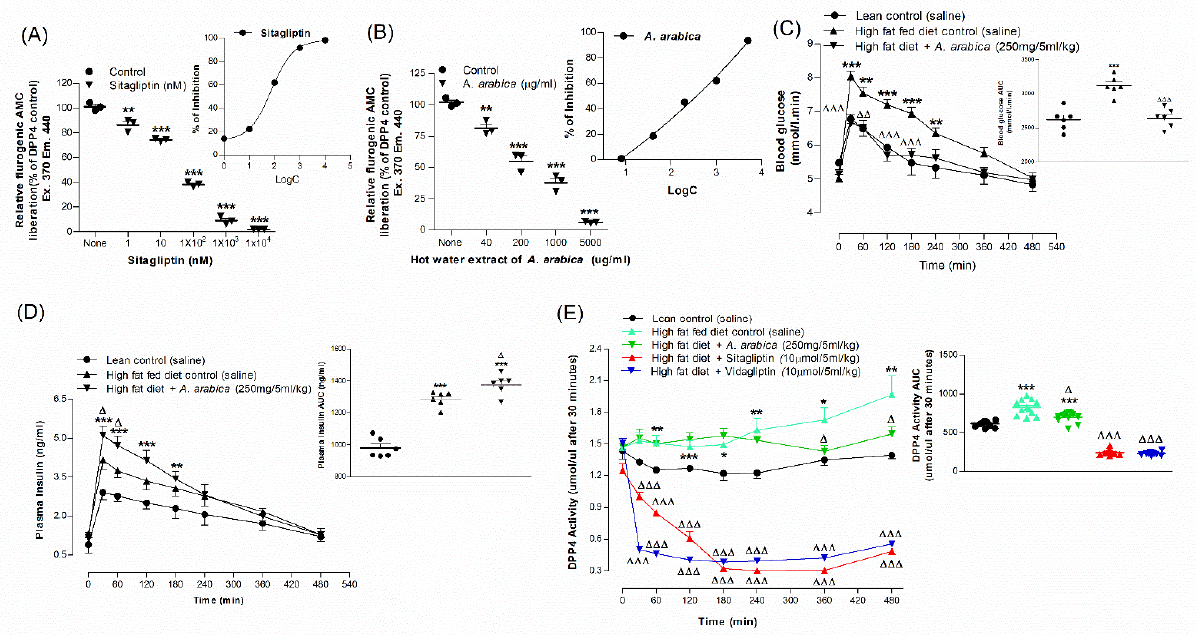
Figure 3. Acute effects of ( A ) sitagliptin and ( B ) hot-water extract of A. arabica bark on DPP-IV enzyme activity in vitro, ( C ) glucose tolerance, ( D ) plasma insulin and ( E ) plasma DPP-IV in high-fat-fed rats. Parameters were measured prior to and after oral administration of glucose alone (18 mmol/kg body weight, control) or with simultaneous A. arabica extract (250 mg/5 mL/kg body weight). Established DPP-IV inhibitors, sitagliptin and vildagliptin, were used as positive controls. Values are the mean ± SEM, n = 3 for DPP-IV enzyme activity in vitro and n = 6 for glucose tolerance, plasma insulin and DPP-IV in vivo. * p < 0.05, ** p < 0.01 and *** p < 0.001, compared to normal control and ∆ p < 0.05, ∆∆ p < 0.01 and ∆∆∆ p < 0.001 compared to high-fat-fed